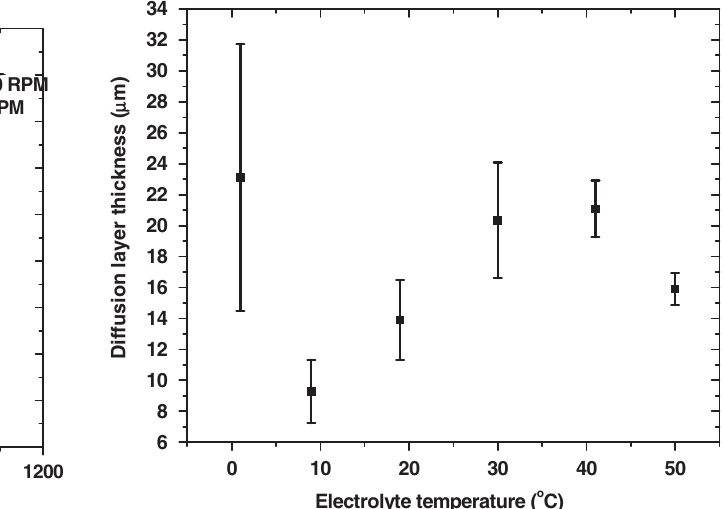
FIG. 6. The effective Nernst diffusion layer thickness of fluo- rine in 1:10 volume ratio HF and H niobium at the different